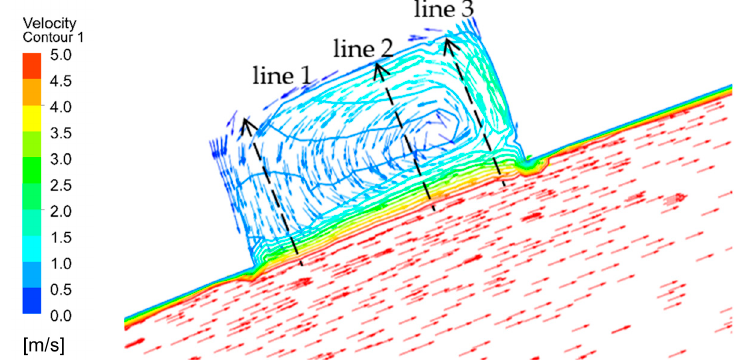
Figure 15. Velocity distribution and streamline of the gas phase.